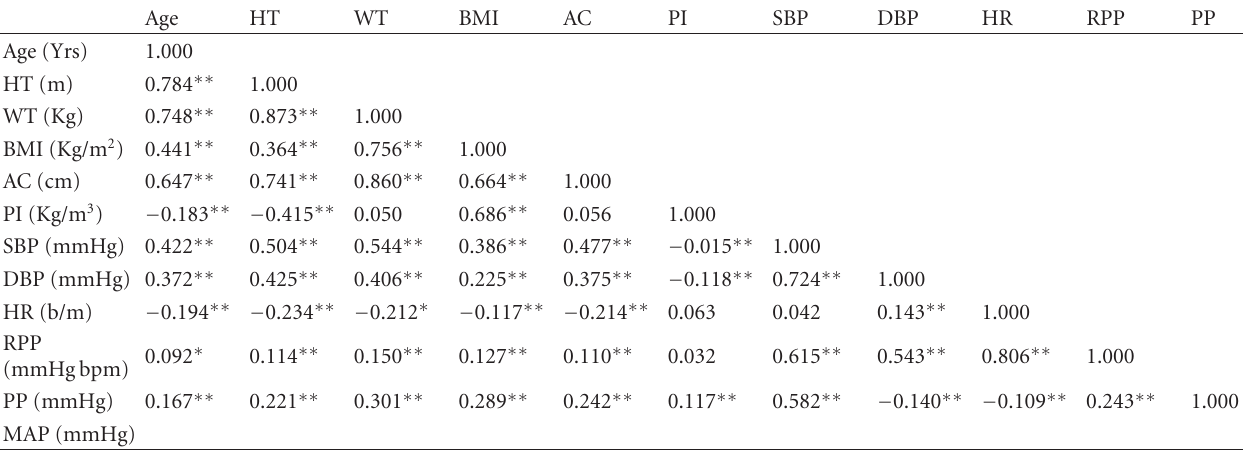
Table 2: Correlation matrix showing the relationship between anthropometric indices and cardiovascular